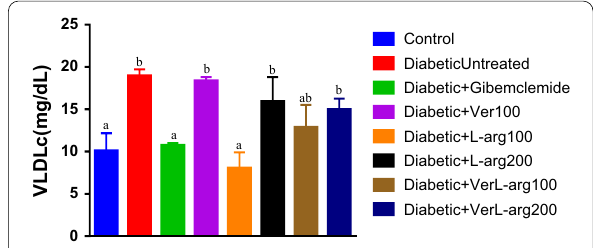
Fig. 10 Very low density lipoprotein cholesterol concentration in diabetic mice treated with verbenone, L-arginine and ratios of verbenone L-arginine (1:1 v/m) After 14 days treatment. values are + expressed as mean SEM, n 5. Values with different superscripts are L-arginine (1:1v/m) ± = + significantly different at p < 0.05. VerL-arg verbenone L-arginine SEM, n 5. = + ± = (1:1 v/m)